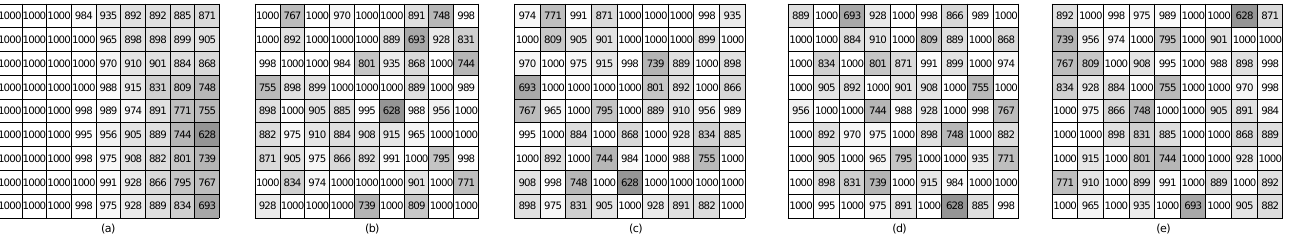
Figure 17. PV array under the right edge of the cloud. ( a ) Before reconfiguration. ( b ) After original- PSO-based reconfiguration. ( c ) After the original-Rao-based reconfiguration. ( d ) After the proposed PSO-based reconfiguration. ( e ) After the proposed-Rao-based reconfiguration.